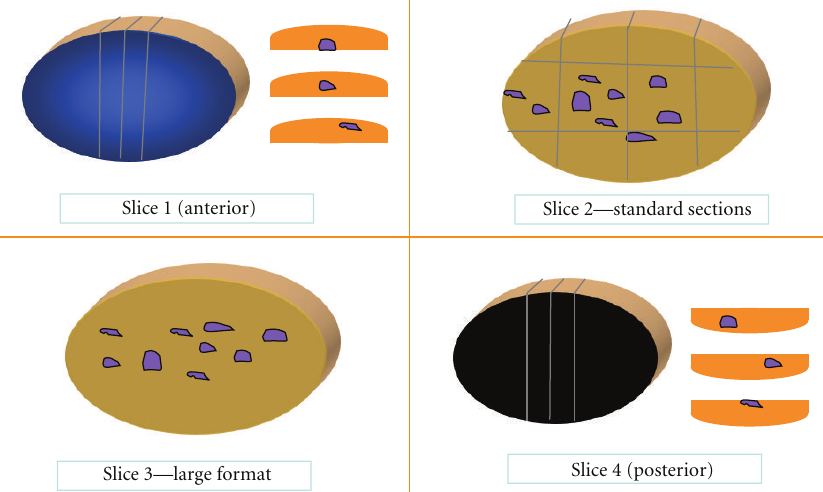
Figure 2: Partial mastectomy cut into four slices. Slice one (top) is anterior and slice 4 (bottom) is posterior. These two are sectioned in the perpendicular plane to evaluate those two margins microscopically. Slice 2 is cut into small pieces and entirely submitted for standard histologic sections. Slice 3 is processed intact for large format